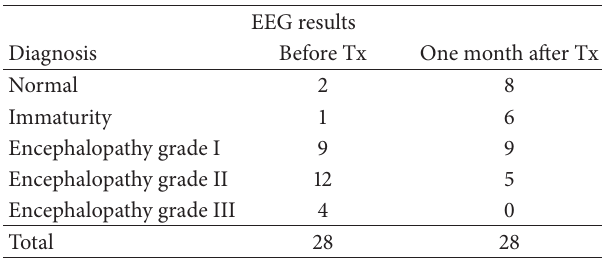
Table 6: Reporting of adverse reactions and